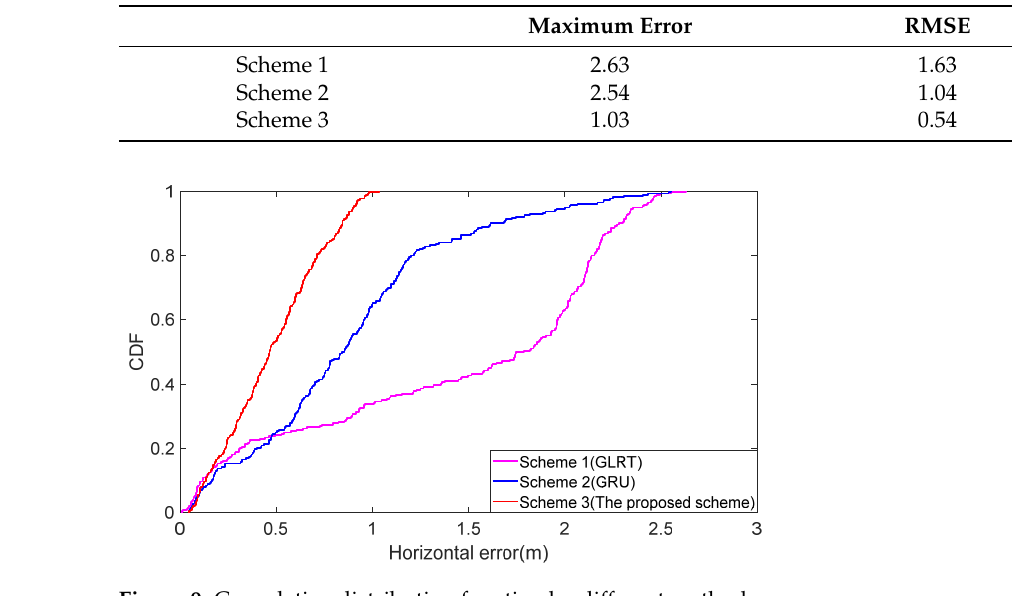
Table 3. Position error (m) obtained by different schemes.